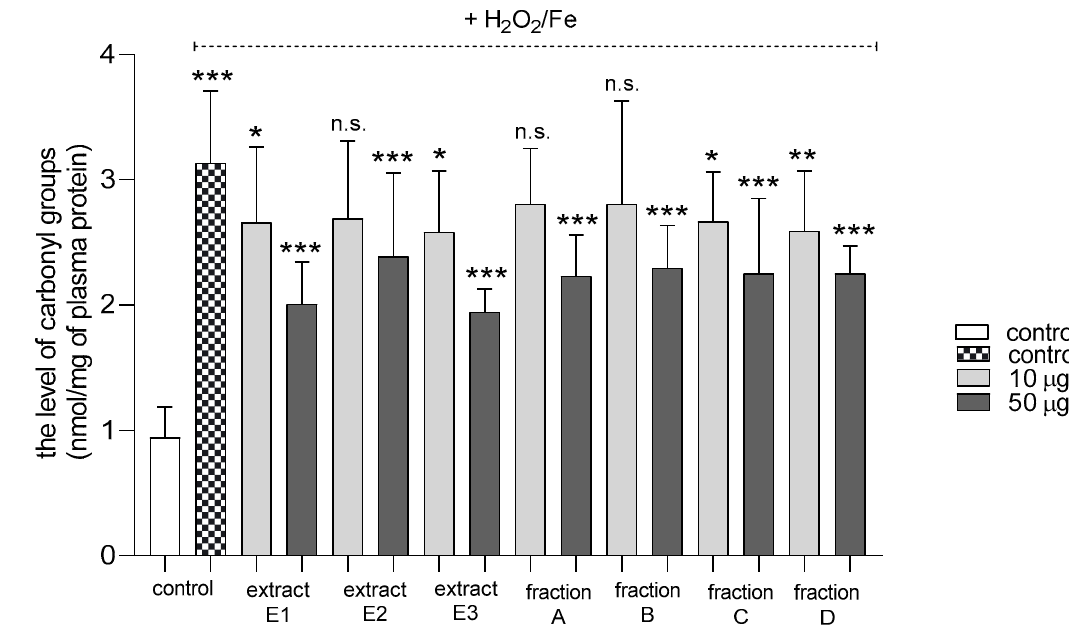
Figure 4. Effects of extracts (E1–E3) and flavonoid fractions (A–D) of dandelion fruits (concentrations 10 and 50 µg/mL) on the levels of carbonyl groups in plasma treated with H 2 O 2 /Fe. The data are presented as means ± SD ( n = 8). Control negative refers to plasma not treated with H 2 O 2 /Fe, and control positive to plasma treated with H 2 O 2 /Fe. Kruskal-Wallis test: n.s. p > 0.05, * p < 0.05, ** p < 0.01, *** p < 0.001, compared with positive control.